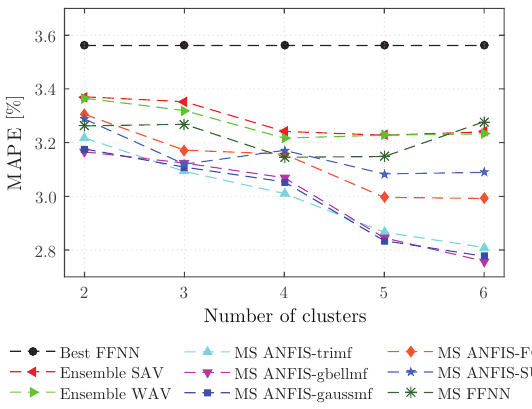
Figure 10: R 2 for different cluster number for testing